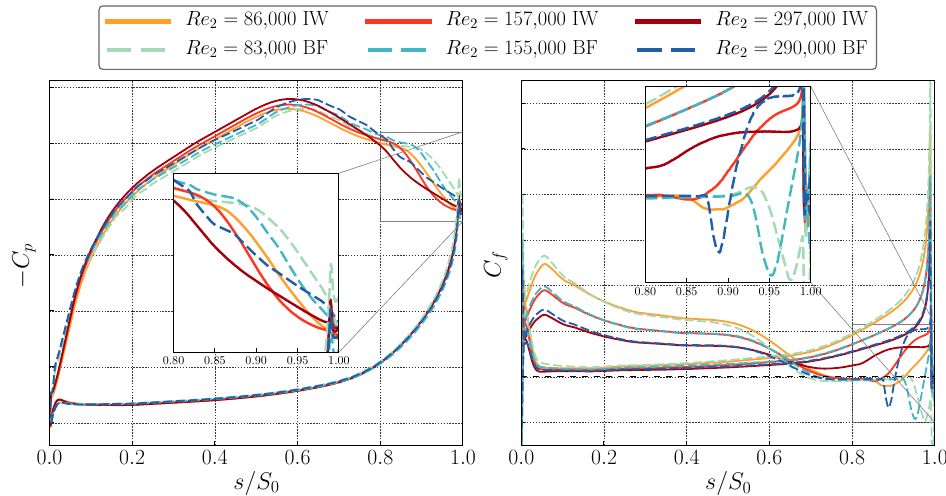
Figure 6. Blade wall distributions with increasing Re 2 , compared with momentum forcing cases at the same flow regime. ( Left ): pressure distribution; ( right ): skin-friction coefficient. Y -axis tick labels are omitted due to data